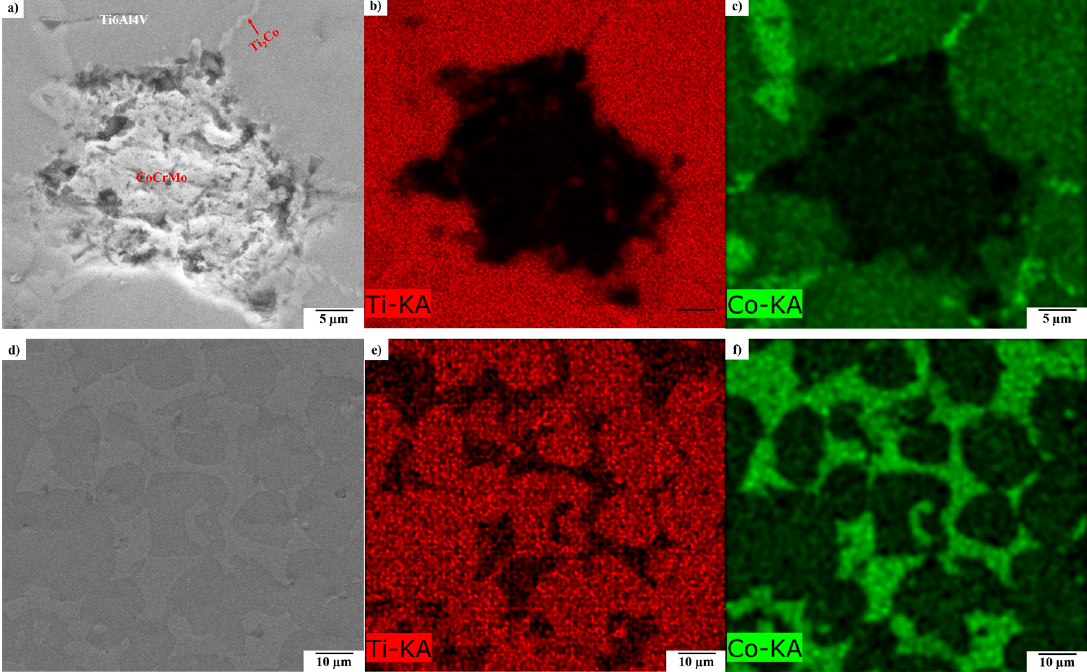
main peaks of the CoCrMo and the main peak of α-Ti phase.